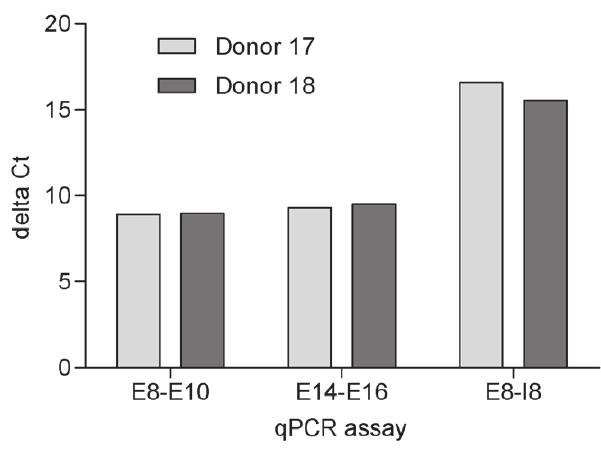
Figure 4. Levels of pre-mRNA and mRNA transcript of IFIH1 are not altered by the rare nsSNP, rs35667974, Ile923Val. Delta Ct calculated using the IFIH1 qPCR minus the single copy gene b 2 microglobulin (B2M) qPCR. Donor 17 is the control individual and donor 18 is heterozygous for Ile923Val. E8-E10: exon 8 to exon 10 qPCR assay, E14-E16: exon 14 to exon 16 qPCR assay and E8-I8: exon 8 to intron